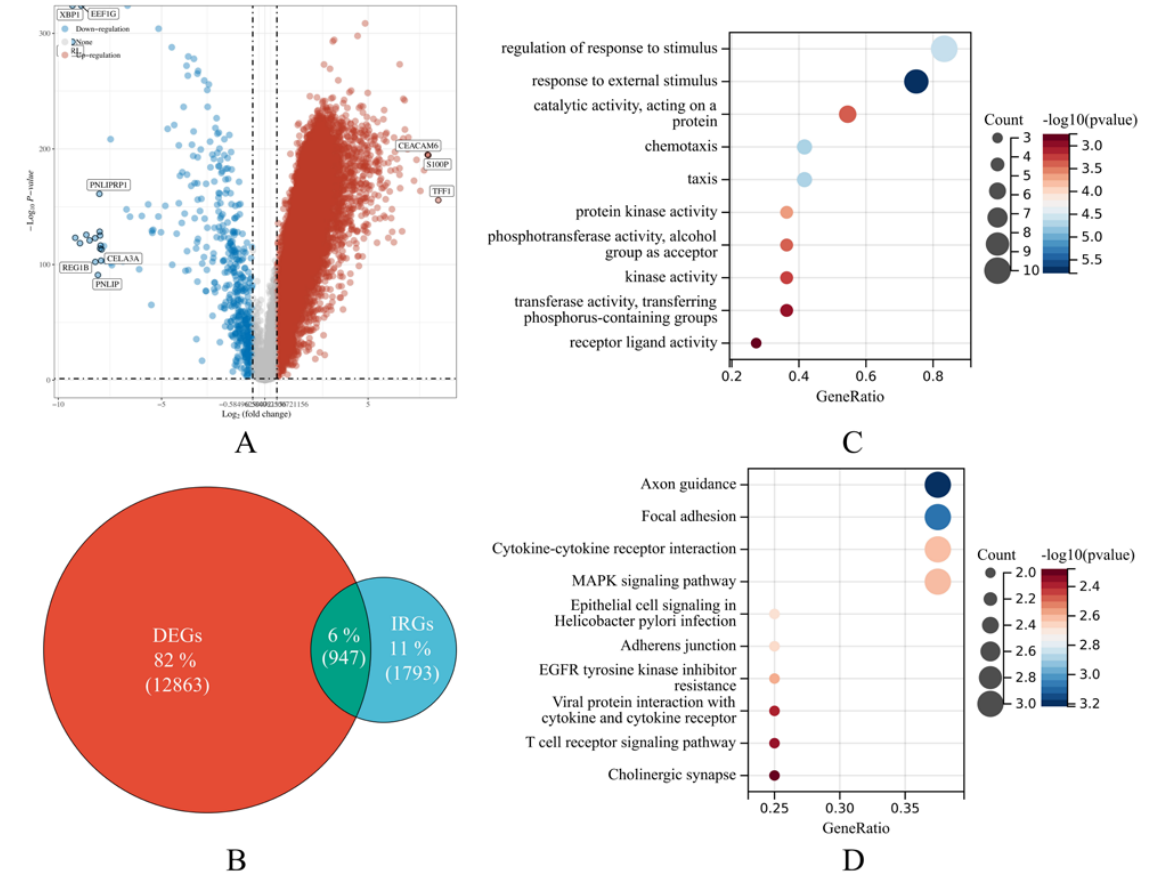
Figure 2. Feature gene selection and overrepresentation analysis outcomes. ( A ) The volcano plot displays the differentially expressed genes (DEGs) in pancreatic adenocarcinoma (PAAD) according to the TCGA data. The spots represent genes. The top 10 DEGs were labeled. Red shows up-regulated expression in tumorous tissues than normal samples, whereas blue represents the reverse. Non-DEGs are in gray. ( B ) The Venn diagram demonstrates the intersection of interest. The green region of the Venn diagram shows the number and ratio of DEIRGs. The red and blue sections show DEGs and immune-related genes (IRGs), respectively. ( C , D ) The bubble plots show gene ontology (GO) and Kyoto encyclopedia of genes and genomes (KEGG) pathway over-representation analyses. The size of the bubble corresponds to the number of genes from our samples found in the GO or KEGG pathway. p -value < 0.05 and FDR < 0.05 are statistically significant.